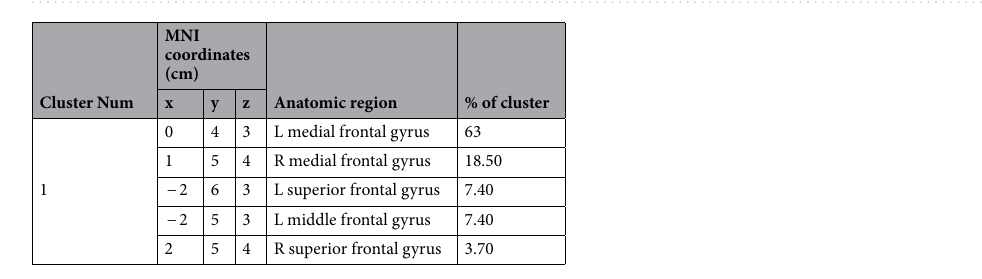
Table 2. Source-level interaction between OT and PL sessions in the M170 time window—size and location of the significant cluster.